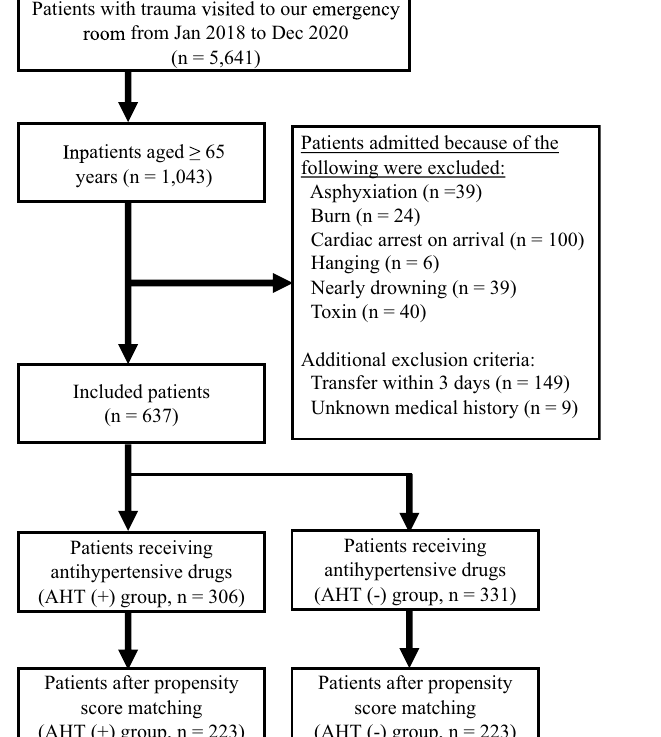
Figure 1. Flow chart of participant